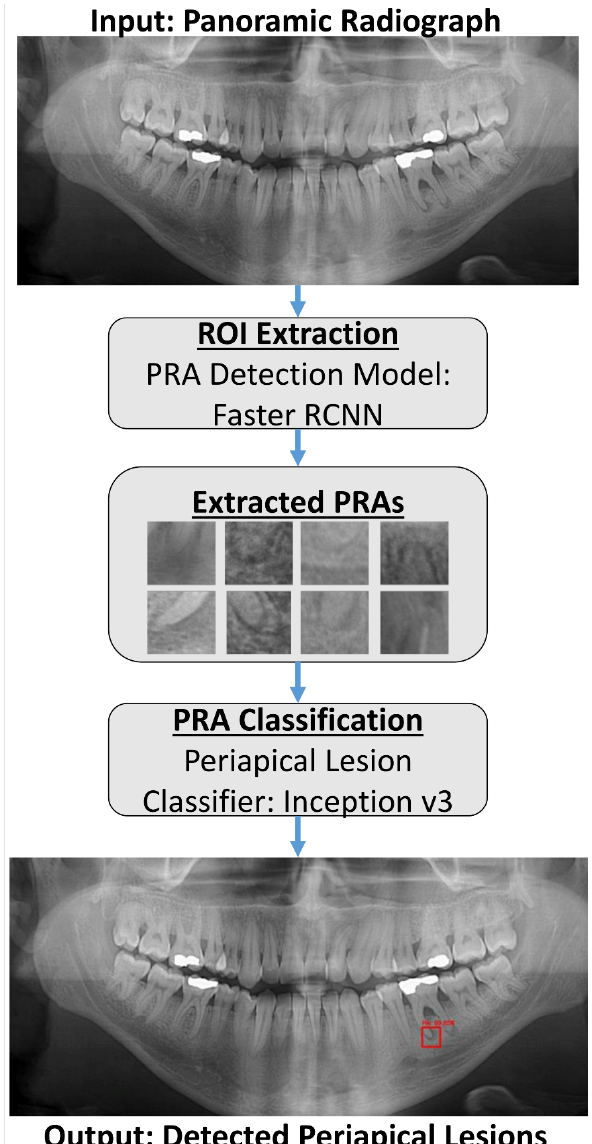
Figure 1. Proposed System Architecture and Workflow of the AI developed in this study. Input: Panoramic radiograph. The system first performs ROI extraction on the input images using the “Faster RCNN” algorithm. Then, the system classifies the extracted PRAs into two possible categories: apices with periapical lesion (PL) or healthy apices (H); this was done using the “Inception v3” algorithm. The final output: the detected periapical lesions depicted by red bounding boxes with the system confidence score depicted on